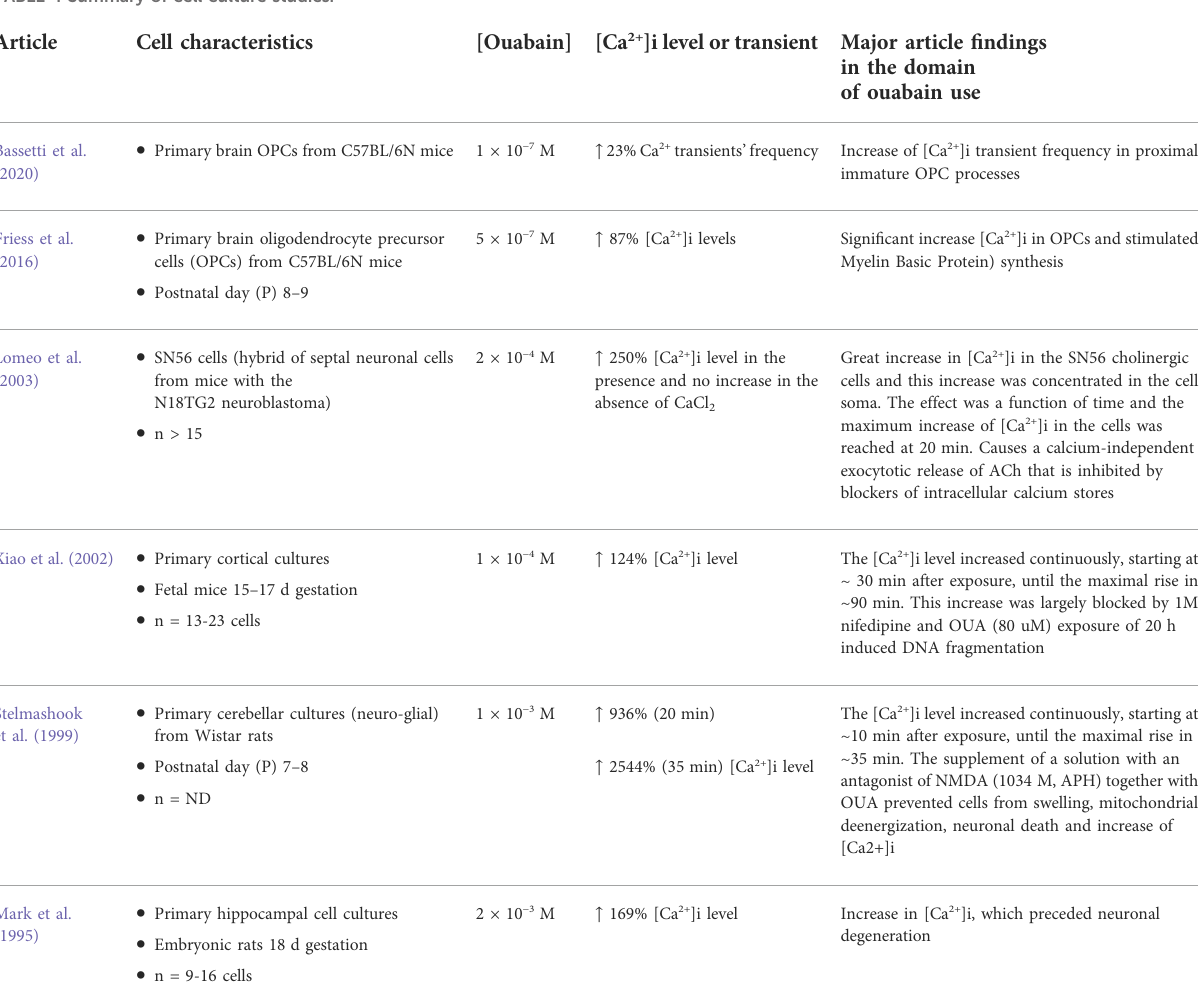
TABLE 4 Summary of cell culture